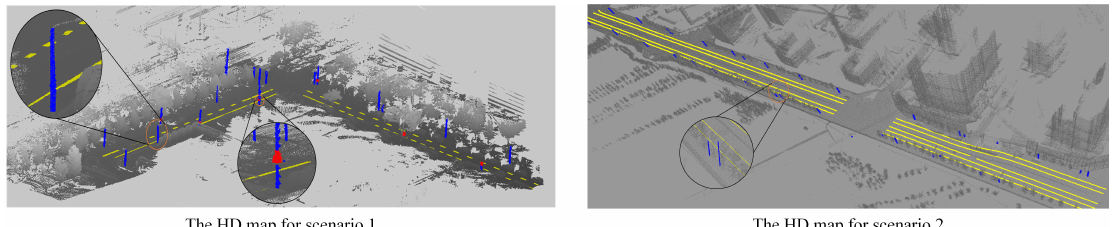
Figure 14. The generated maps used in MLVHM. Lamp poles denoted in blue, lane lines in yellow, and traffic signs in red.